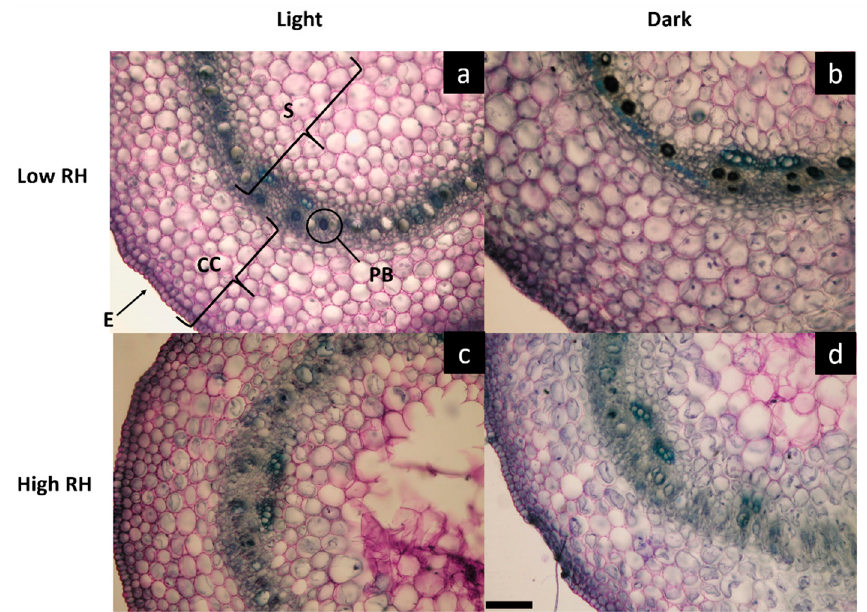
Figure 1. Light microscopy views of cross-sections of hypocotyls of mung bean sprouts grown under the four different combinations of RH and LR: ( a ) LowRH-L; ( b ) LowRH-D; ( c ) HighRH-L; ( d ) HighRH-D, High RH in dark regime). Stele (S), Cortical cylinder (CC), Epidermis, (E) and Phenolic bodies (PB). Images are at the same magnification; scale bar = 100 µm.